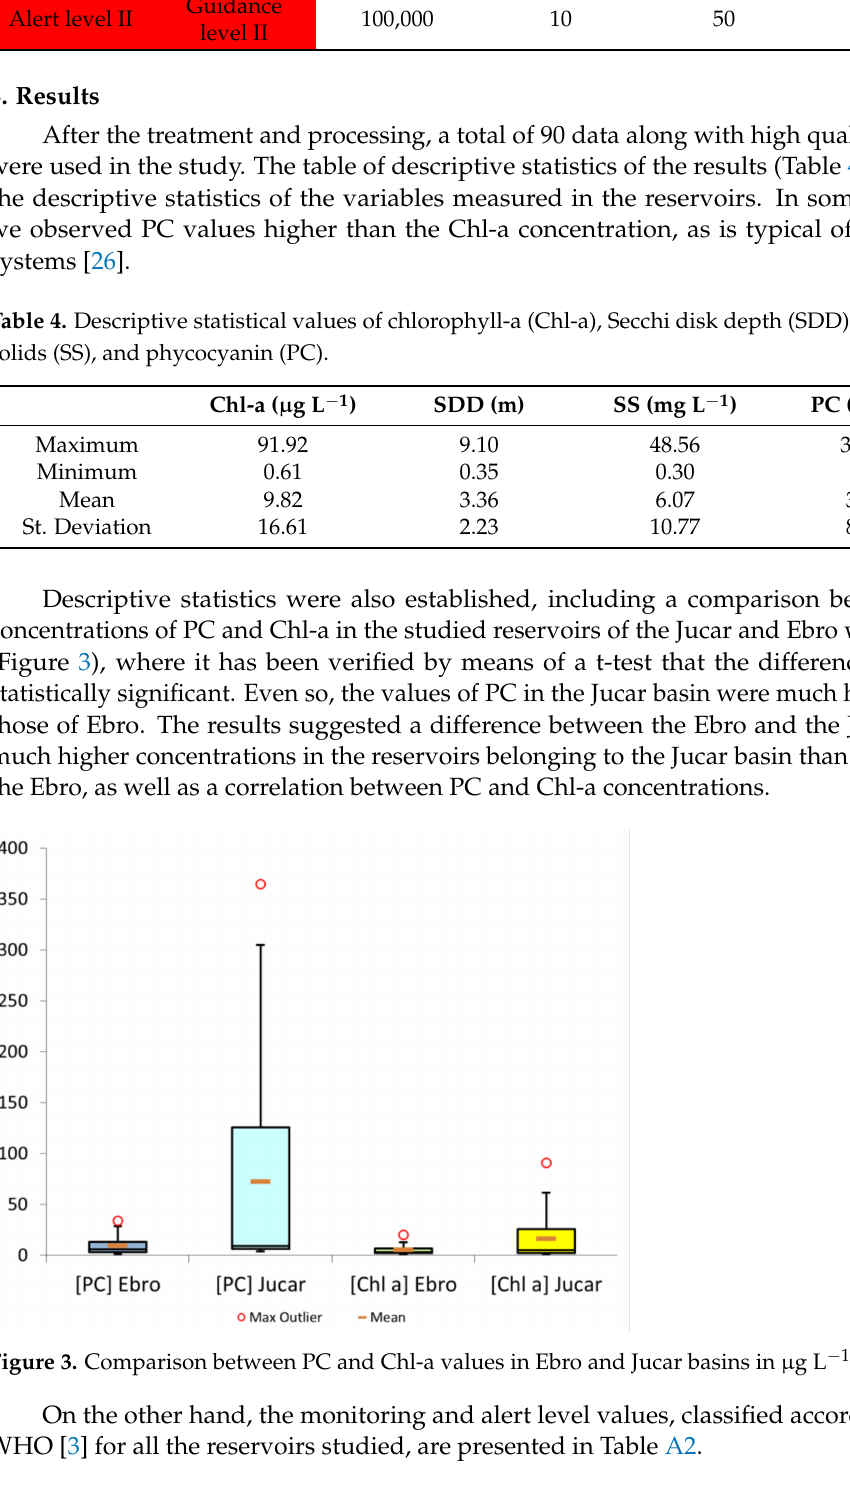
Table 3. Classification according to WHO, with the modifications of density, biovolume, and chlorophyll-a according to [29], and phycocyanin according to [18]. Density Biovolum Drinking Bath Water (Cell mL − 1 ) Water Surveillance level 200 0.02 0.1 <0.1 Alert level I 2000 0.2 1.0 4 Guidance 20,000 2 10 30 ± 2 level I Guidance 100,000 Alert level II level II